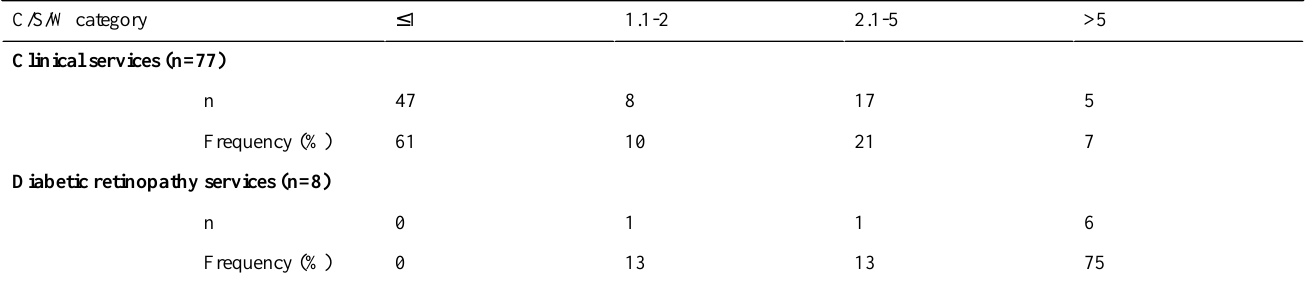
Table 3. The number of programs (n) and percentage frequency based on the 4 categories of use for clinical telemedicine and diabetic retinopathy screening